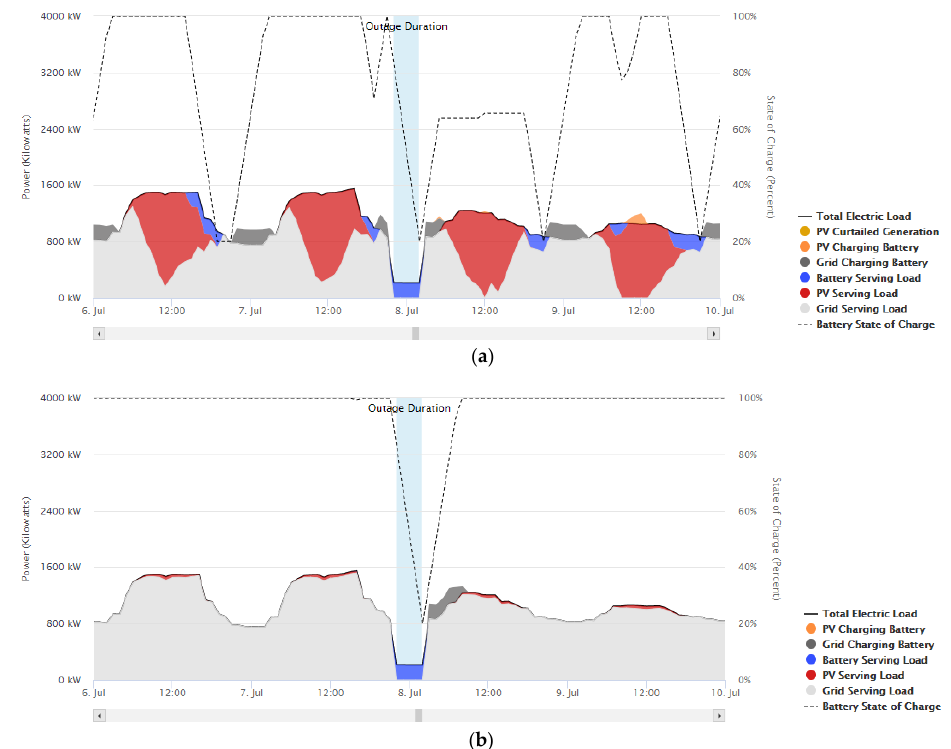
Figure 7. System operation under ( a ) ToU rate and ( b ) flat rate with 4-h outage at 10 p.m.